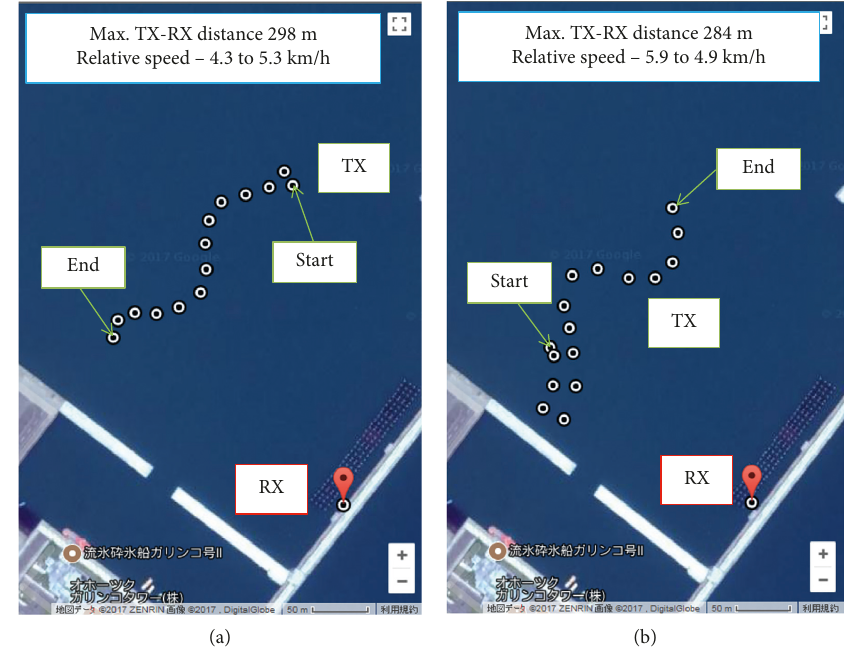
Figure 11: Locations of transmitter and receiver units on Google Maps [12]. (a) Test 1 and (b) Test 2.